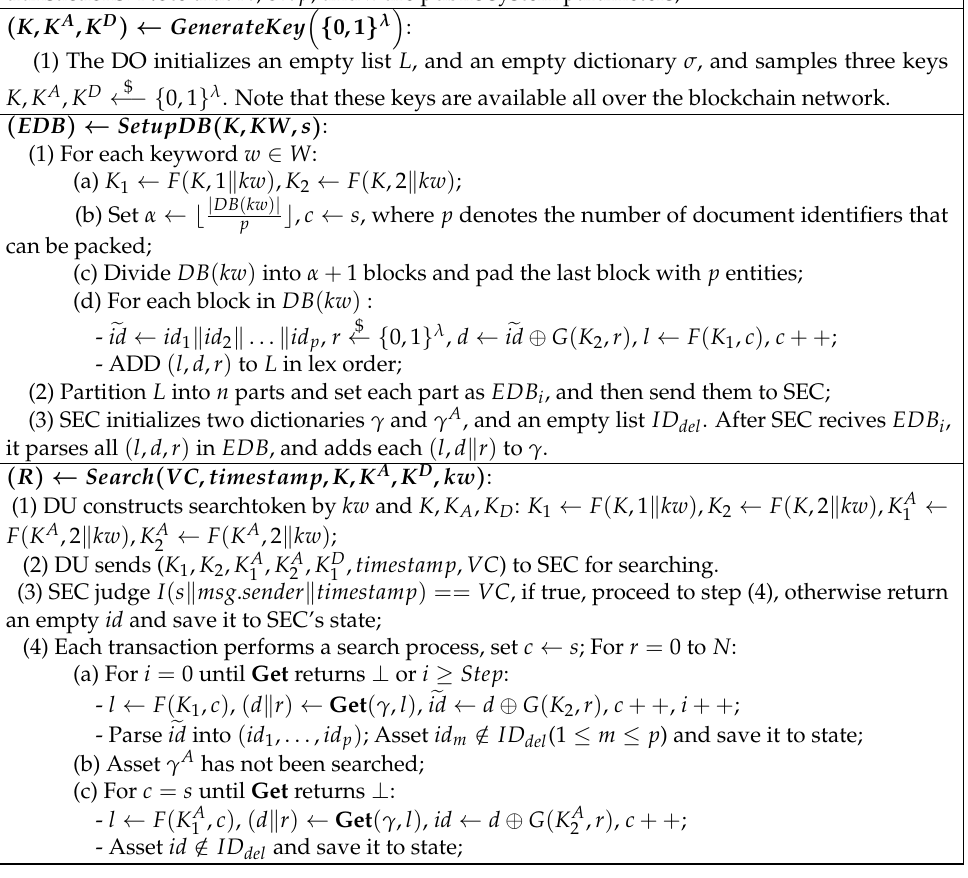
Figure 4. Part I of Π SE